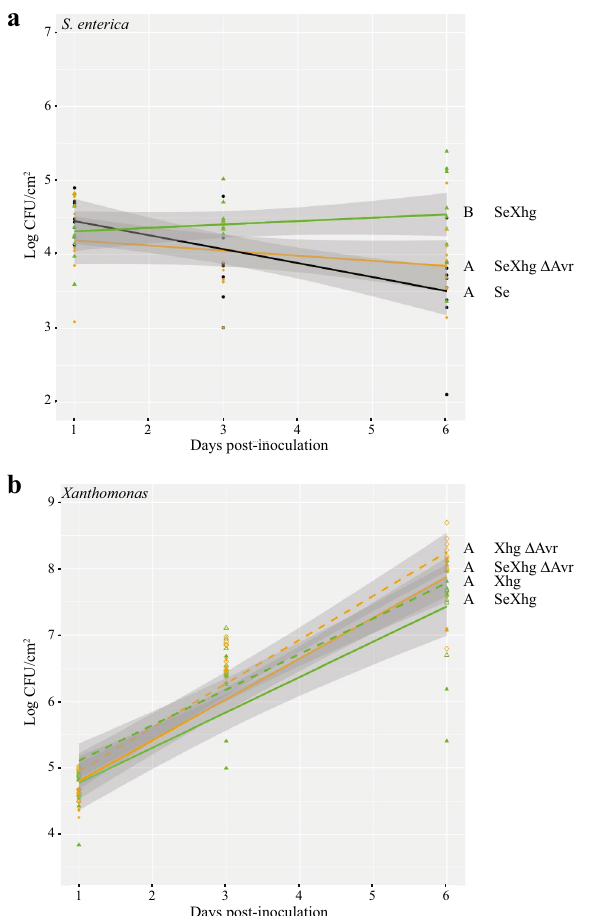
Figure 1. TALE AvrHah1 is required for Xhg -dependent effects on S. enterica persistence. Bacterial populations ( S. enterica , ( a ); Xanthomonas ( b )) on tomato leaves were monitored following treatment with S. enterica (Se; black circles), Xhg (Xhg; open green triangles), Xhg avrHah1 ΔDBD mutant (Xhg ΔAvr; open orange diamonds), S. enterica + Xhg (SeXhg; closed green triangles), or S. enterica + Xhg avrHah1 ΔDBD mutant (SeXhg ΔAvr; closed orange diamonds). All data points from three independent experiments are presented as log CFU/cm 2 . Lines (black, S. enterica, Se; dashed green, Xhg, Xhg; dashed orange, Xhg avrHah1 ΔDBD mutant, Xhg ΔAvr; solid green, S. enterica + Xhg, SeXhg; solid orange, S. enterica + Xhg avrHah1 ΔDBD mutant, SeXhg ΔAvr) correspond to a linear regression model with 95% confidence intervals represented by the shaded areas. Letters denote significant differences between treatments for the regression lines according to the linear regression model ( P < 0.01). Combining three independent experiments, n = 9 plants per treatment per time